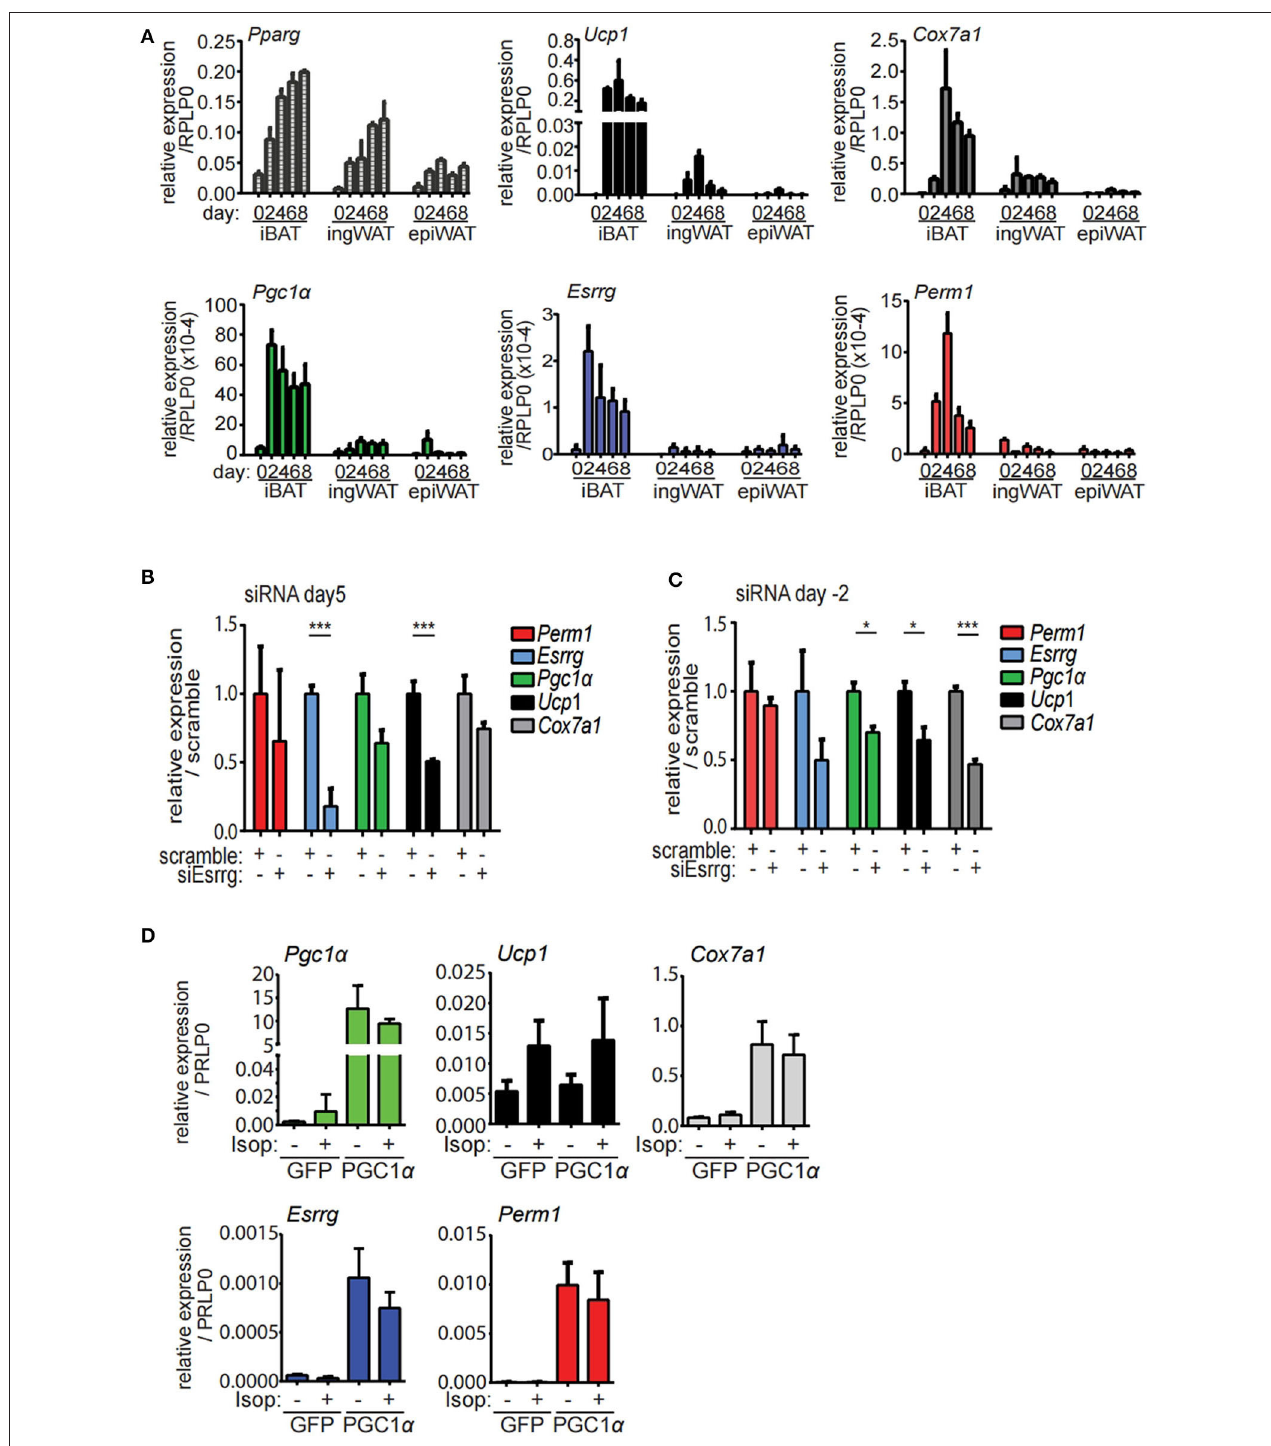
FIGURE 4 | Esrrg and Perm1 have low expression levels in vitro but can be induced in a PGC1 α dependent manner. (A) Time course of in vitro brite/beige adipocyte differentiation of SVF derived from iBA, ingWA or epiWA of 129/SV mice. Pparg (all isoforms) is shown as general adipocyte marker, Ucp1, and Cox7a1 as markers for brown adipocytes. Data are presented as relative expression to reference gene RPLP0 with SEM ( n = 3). (B) Gene expression in immortalized brown mature